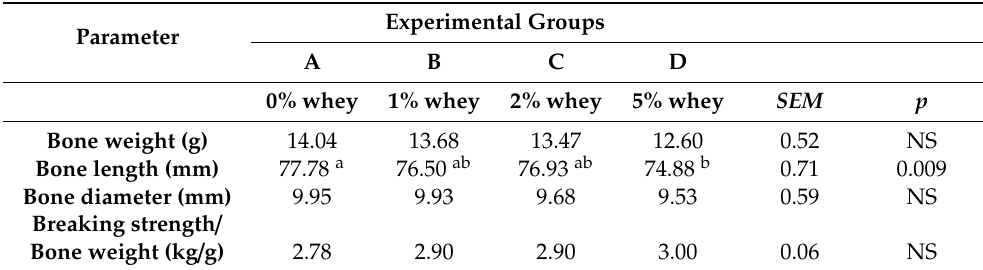
Table 6. E ff ect of whey in various concentrations in poultry diets on the morphology and breaking strength of